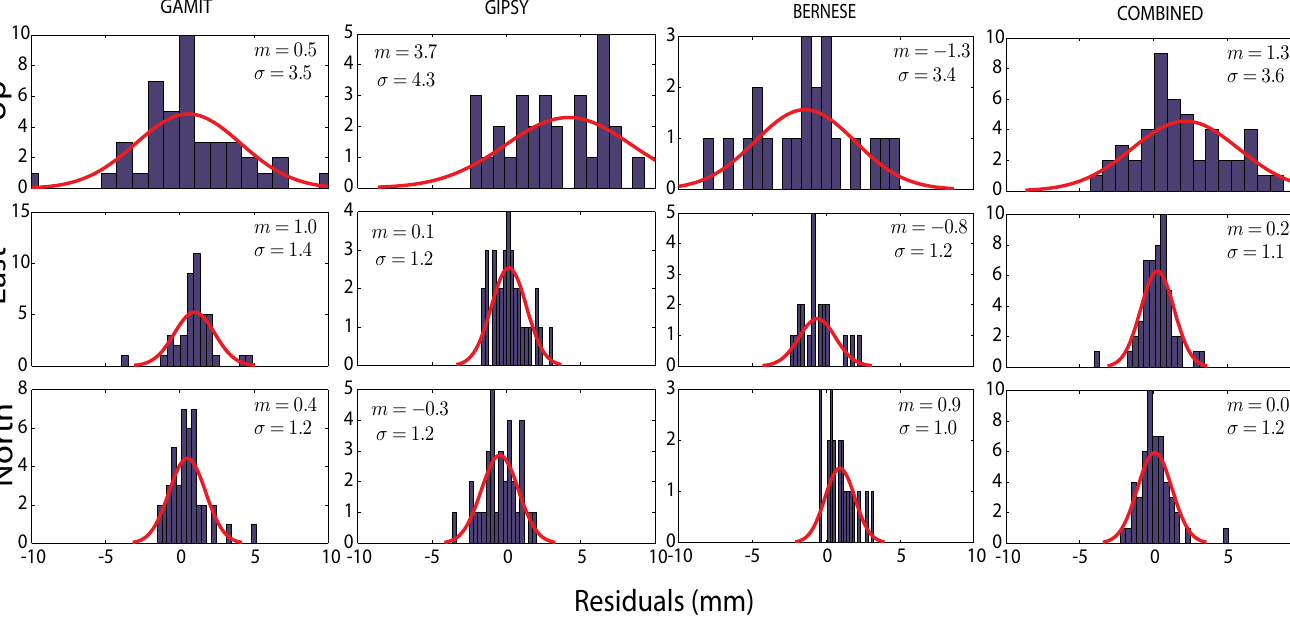
Figure 6. Distribution of the far-field offsets for the individual (BERNESE, GAMIT and GIPSY) and COMBINED May 29, 2012, solutions. Red line, best- fit Gaussian curve. The median (m) and dispersion ( v ) are computed for the three spatial directions (up, east, north).